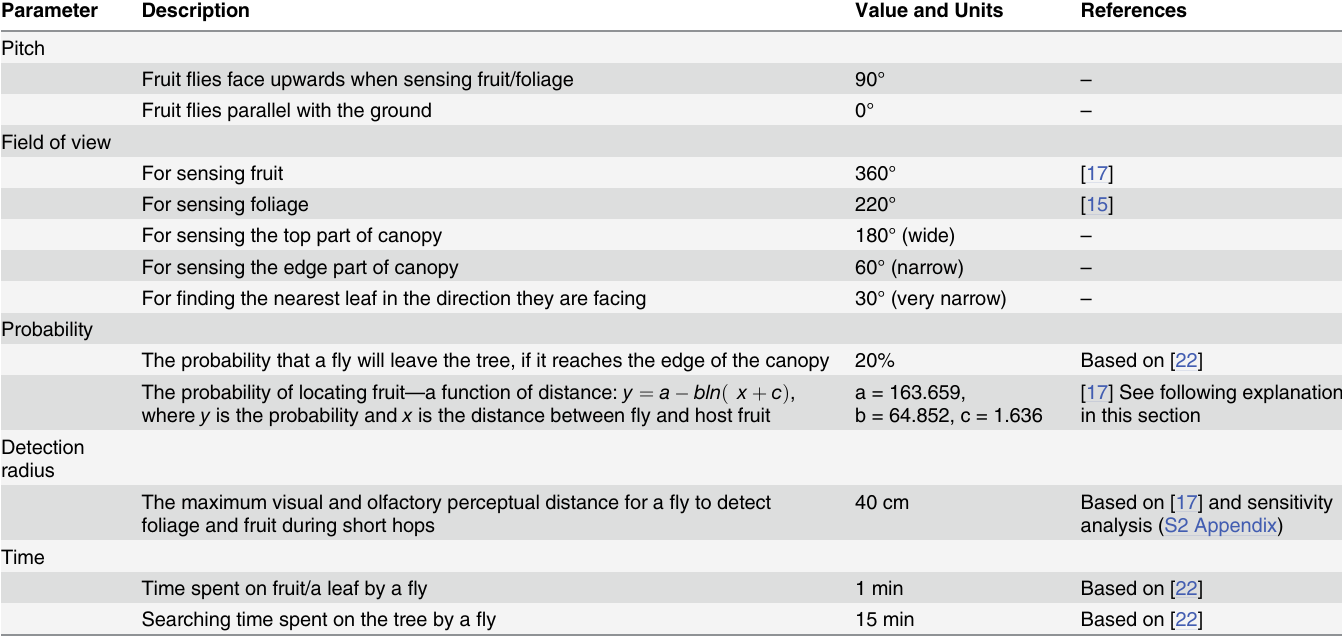
Table 1. Overview of parameters in the generic individual-based spatially explicit model for fruit fly movement within a simulated tree canopy with fruit